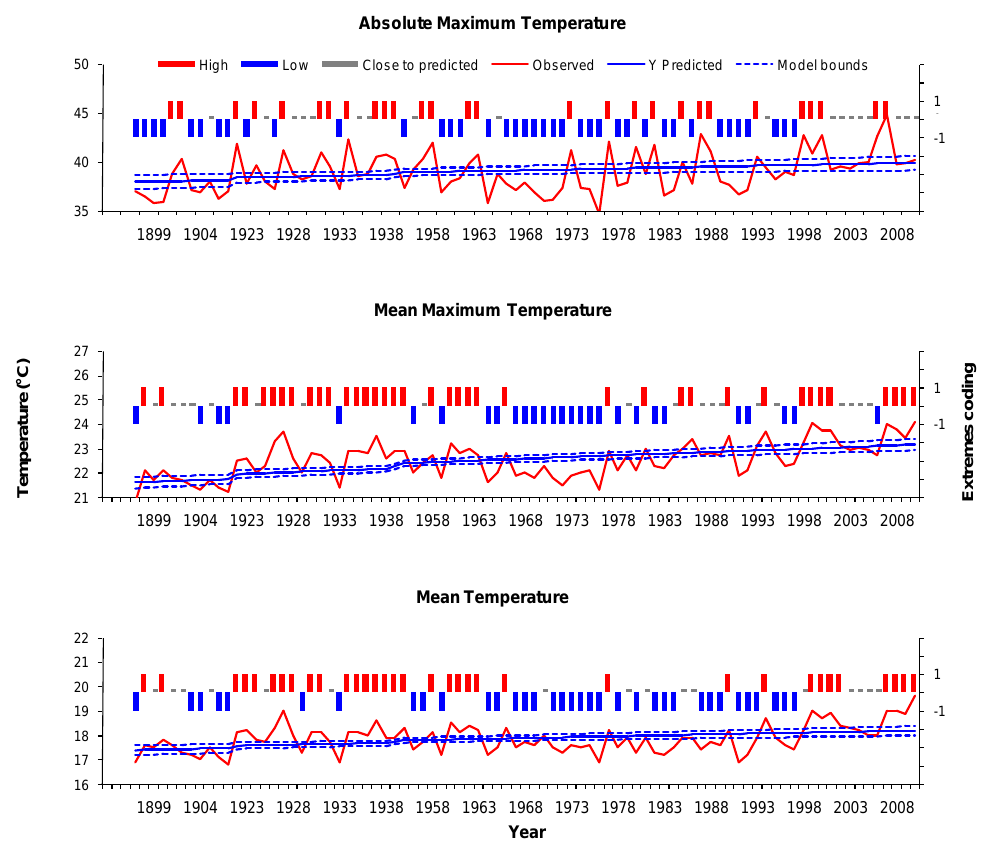
Fig. 4. Trend lines and the 95% confidence intervals of the model around the trend line of air-temperature-related meteorological parameters (absolute maximum, mean maximum and mean air temperature). These are used as bounds to define strongly positive (red columns), strongly negative (blue columns) and close-to-predicted (grey columns) values of fire